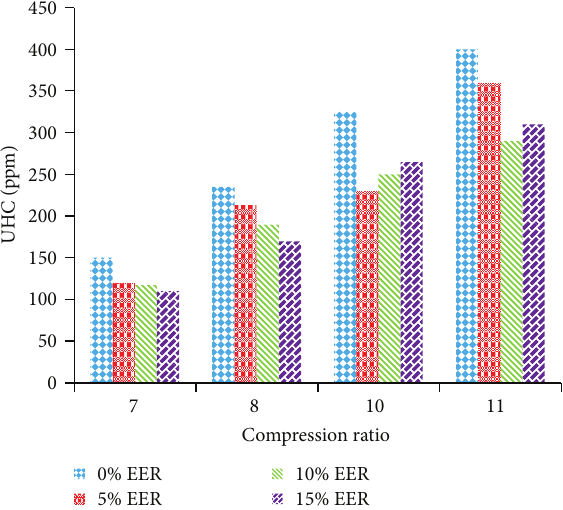
Figure 10: Effect of compression ratio on CO 2 concentration for different EER at 1200rpm and load 14N ⋅ m.